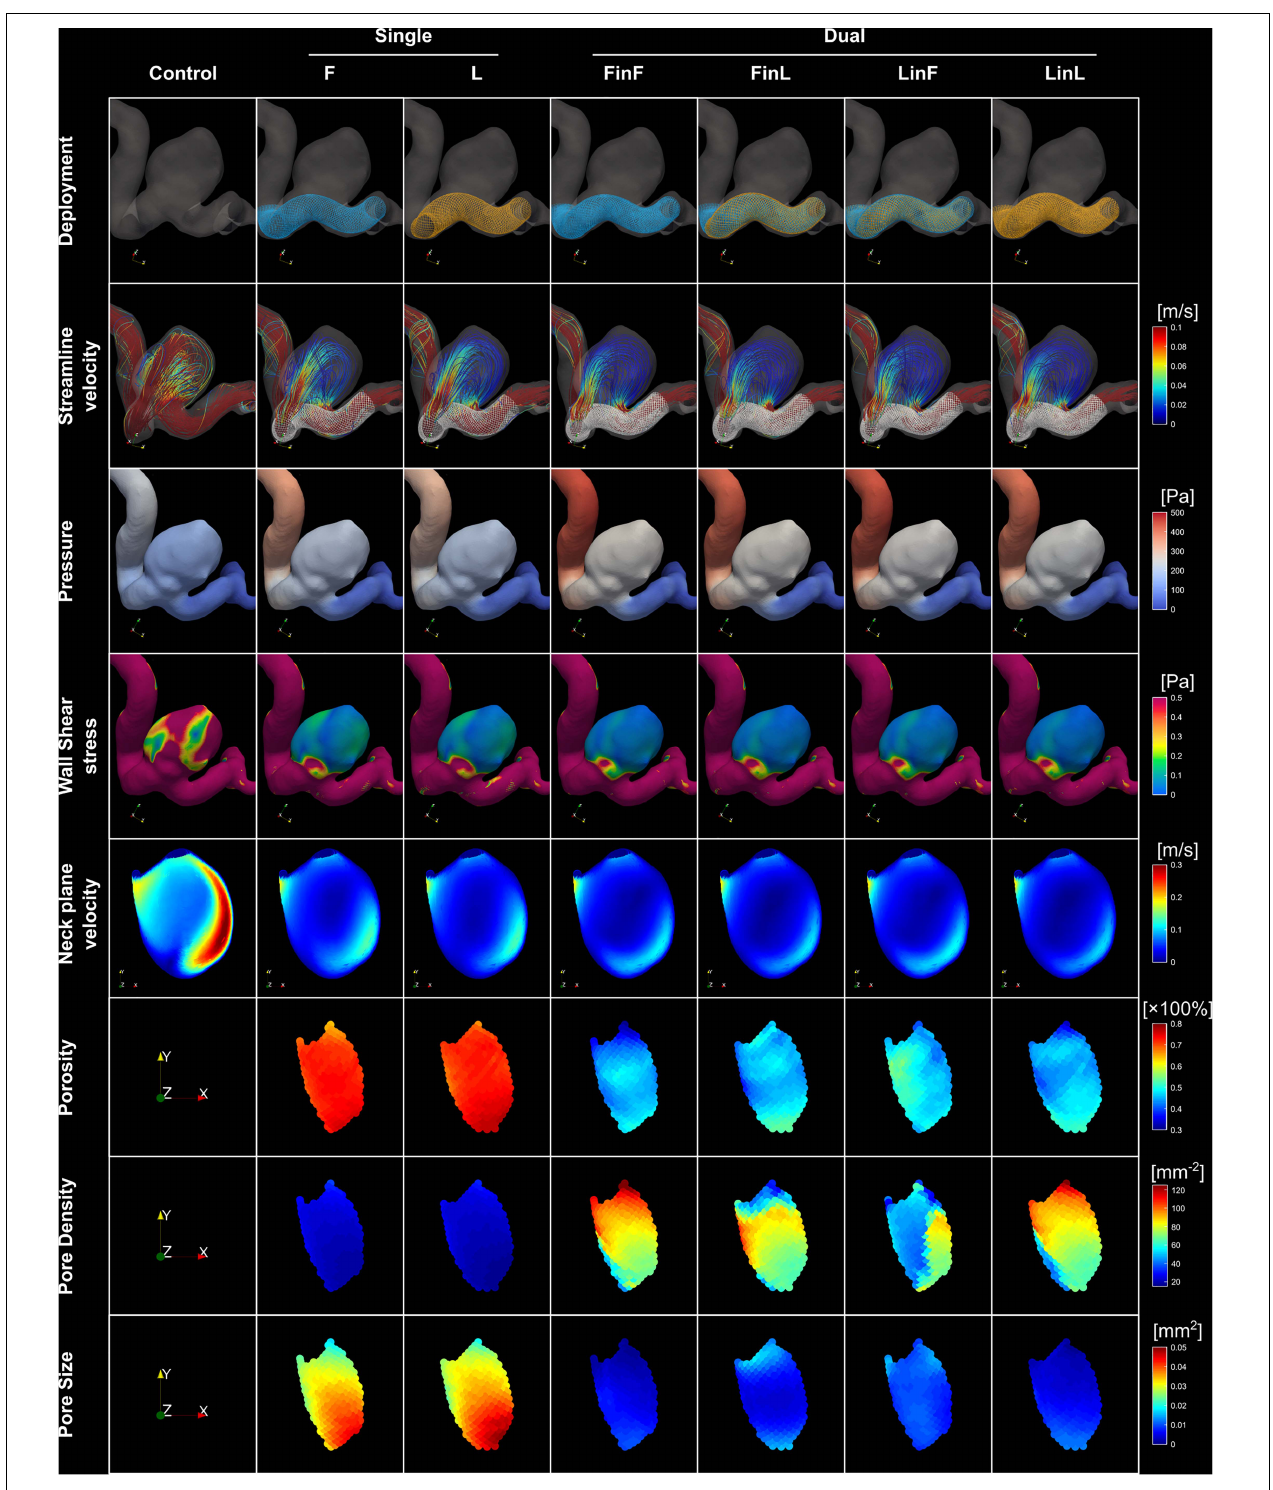
FIGURE 2 | (i) Visualisation of stent structures corresponding to different treatment scenarios ( first row ); (ii) visualisation of streamlines, pressure and WSS distributions corresponding to each treatment mode ( rows two to four ); (iii) velocity distributions on the reference neck surface ( row five ); and (iv) distributions of the porosity, pore density, and pore size on stent nodes within the aneurysm orifice ( last three rows ) for a representative patient aneurysm (Case ID: C0016).